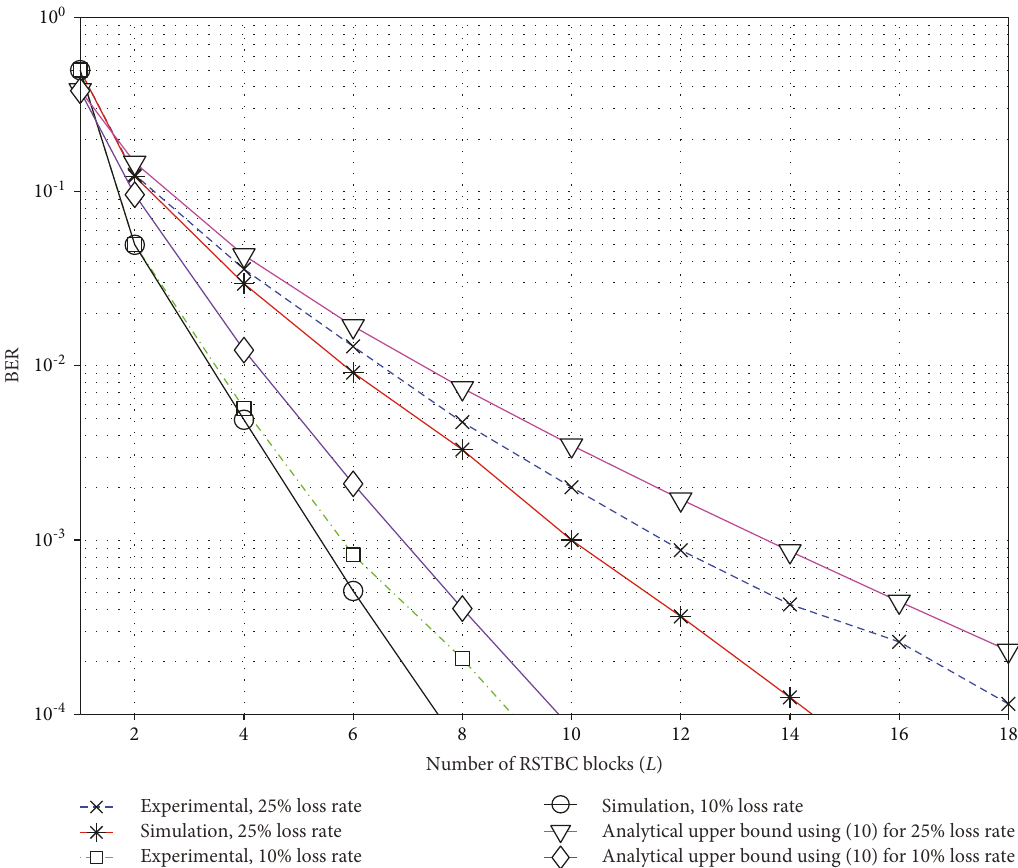
Figure 6: BER versus the number of blocks of RSTBC for experimental, simulation, and analytical upper bounds, in a 2 × 2 MIMO-OFDM system, with QPSK and loss rates of 10% and 25%. The left three curves are for 10% and the right three curves are for